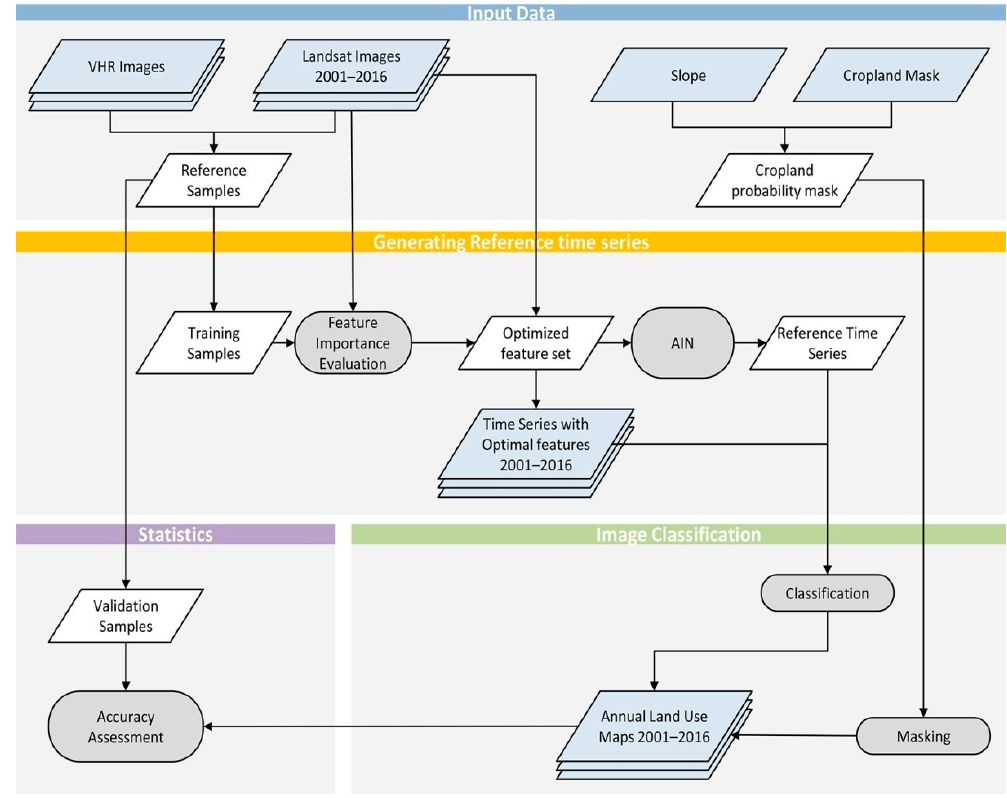
Figure 2. General flowchart to create annual cropland maps. VHR, very high resolution images, AIN, artificial immune network.